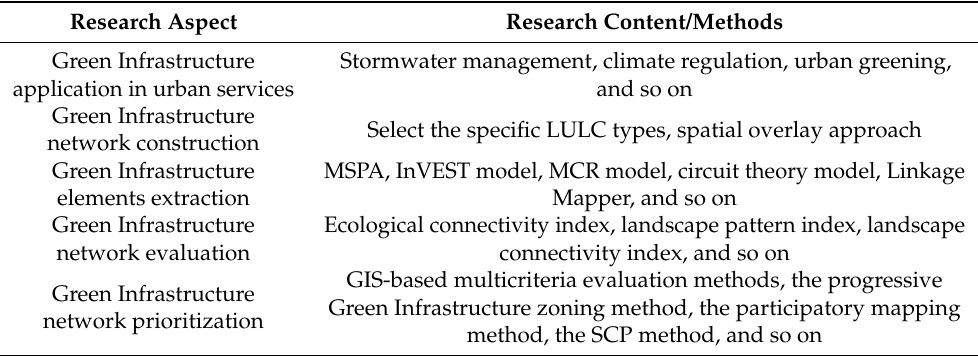
Table 1. The content and methods of Green Infrastructure